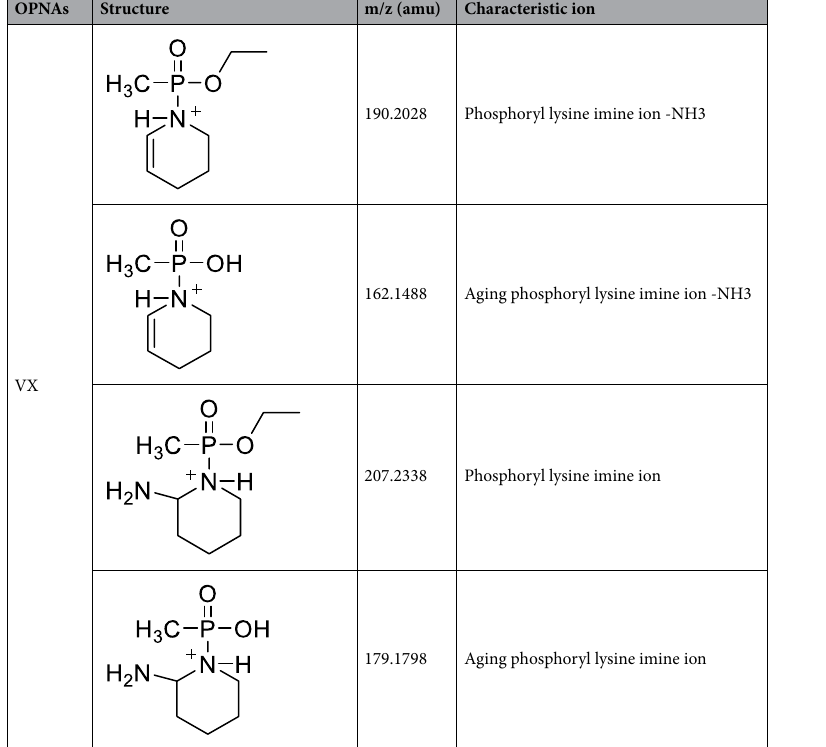
Table 7. Characteristic ions of albumin adducts at lysine residue.